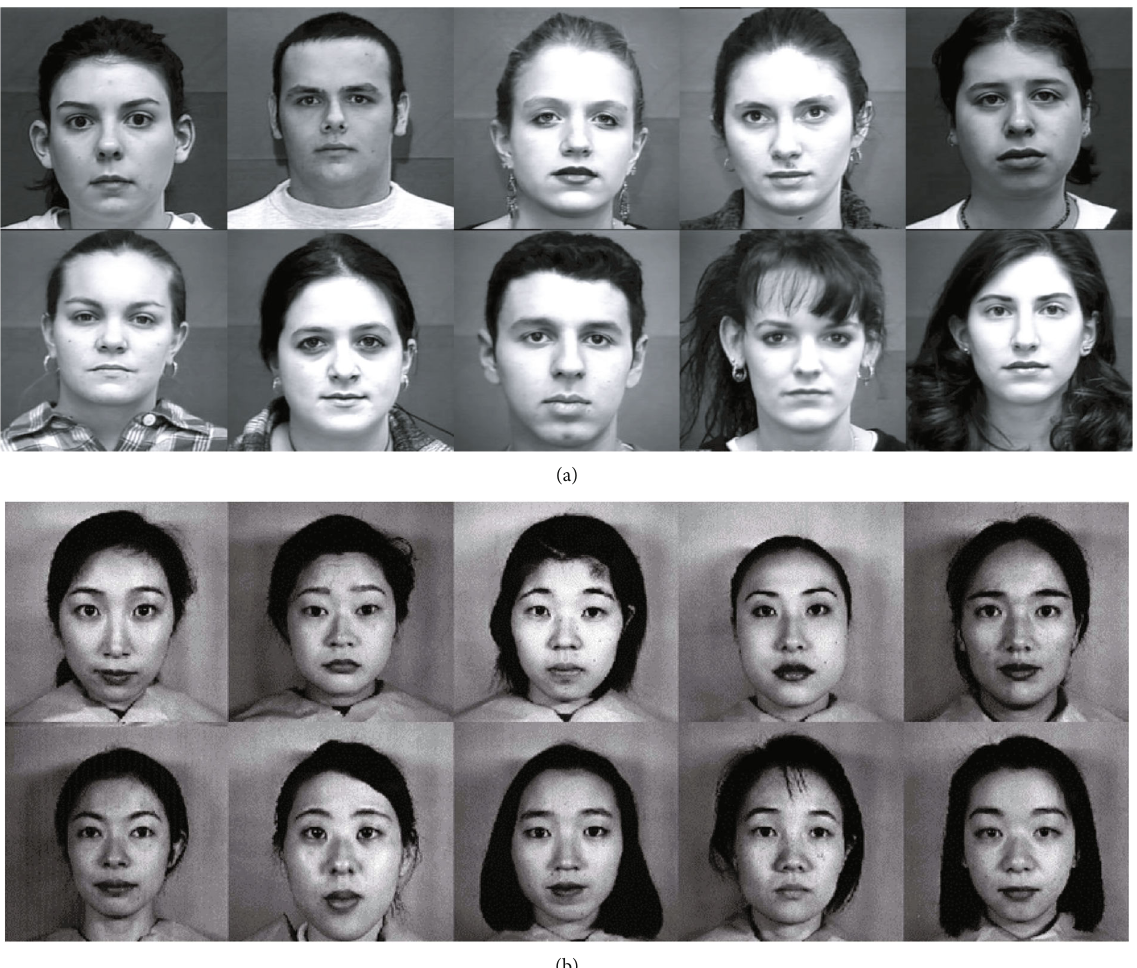
Figure 1: Train-image database: (a) sample of subjects in the CKFE database; (b) subjects in the JAFFE database.